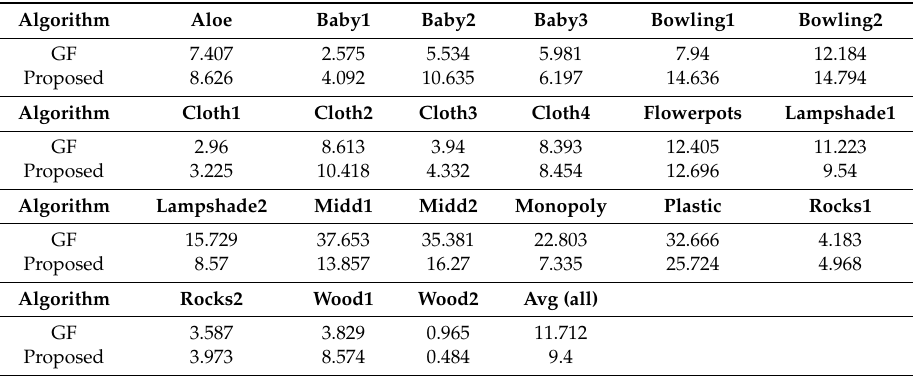
Figure 10. Comparison of the original cost aggregation method with our proposed method for the Middlebury dataset. From top to bottom: Lampshade1, Lampshade2, Midd1, Midd2, Monopoly, Plastic. ( a ) Left images; ( b ) ground truth maps; ( c ) results of the local stereo matching method based on traditional guided filter; ( d ) error maps for the method based on traditional guided filter; ( e ) results of the proposed method; ( f ) error maps of the proposed method. Table 5. Percentage of bad pixels for the Middlebury 2006 dataset.